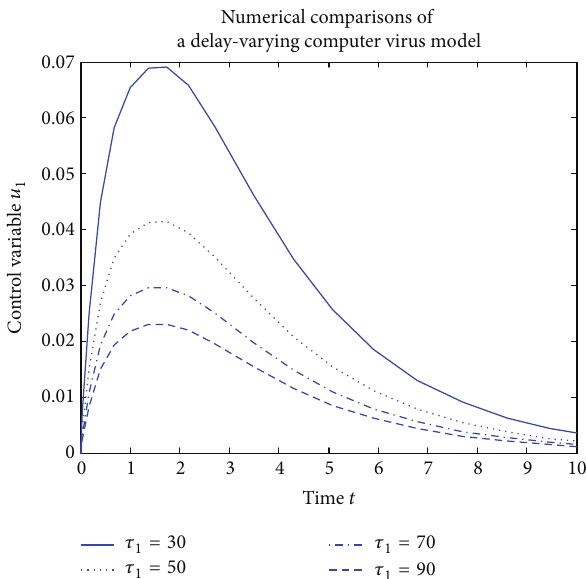
Figure6:Thecontrolvariable 𝑢 1 (𝑡) versustime 𝑡 fordifferentweight